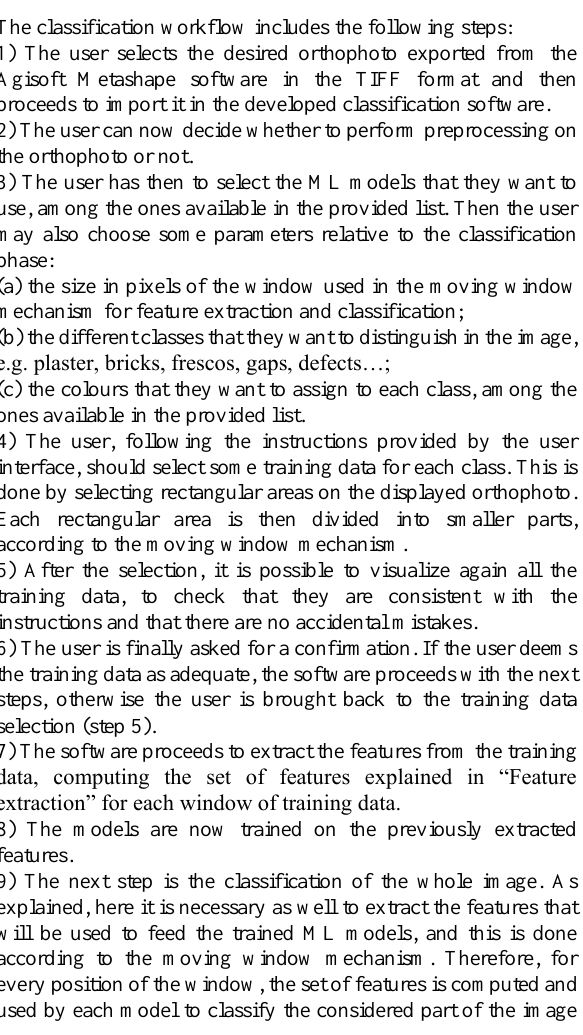
Figure 7. Scheme of DORA classification workflow.